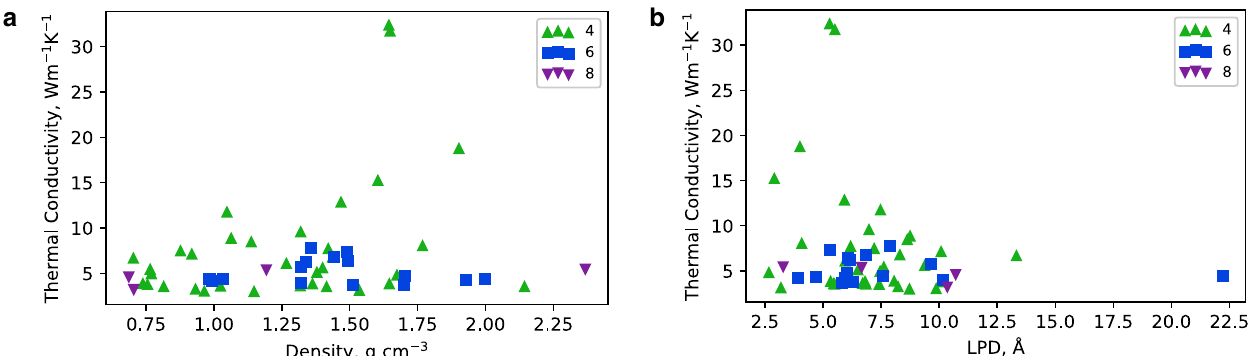
Fig. 7 Relationships of the average thermal conductivity of the top 53 high-k MOFs with density and LPD colored by metal node connectivity. a thermal conductivity and density; b thermal conductivity and largest pore diameter (LPD). Colors: green (4-connected), blue (6-connected), and purple